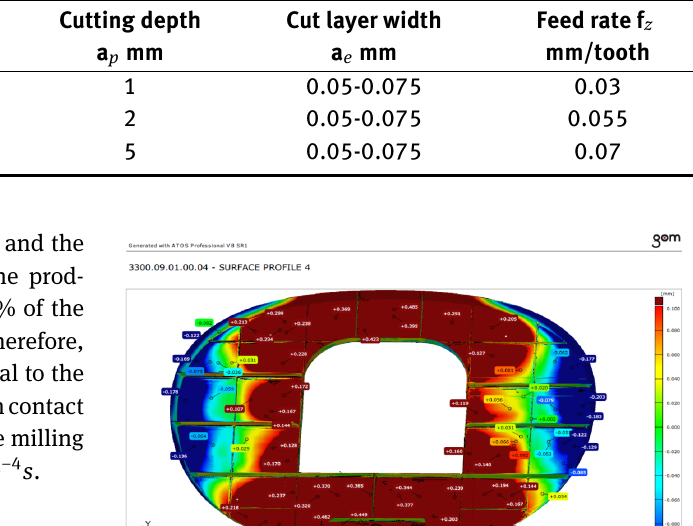
Table 2: The cutting parameters used during the frame machining No.